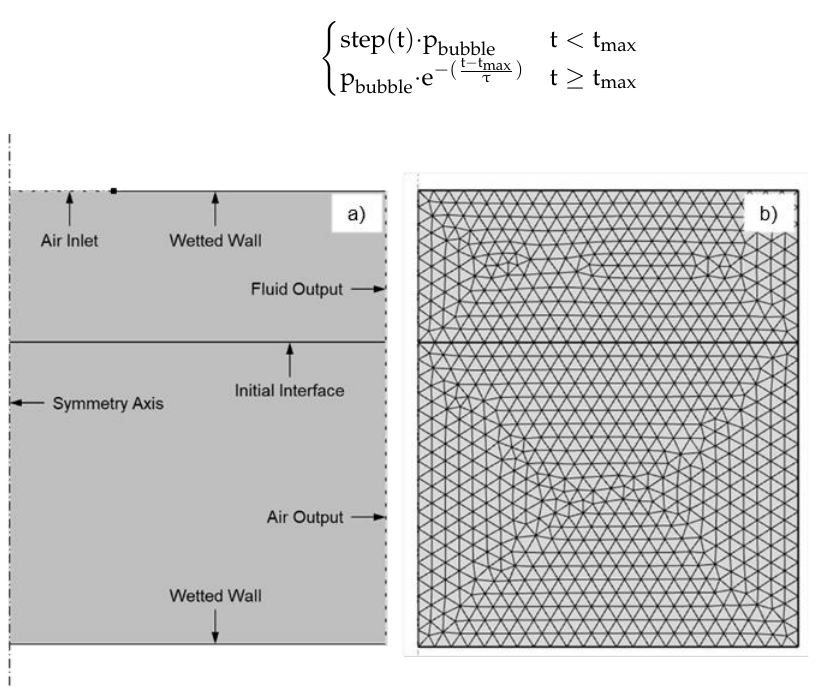
Figure 3. 2D axisymmetric model sketch for the transference of high-viscosity pastes ( a ) and its mesh, which has been magnified to allow observing the elements inside ( b ).